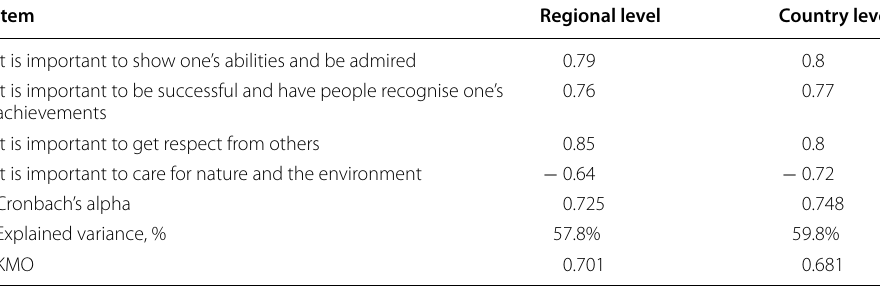
Source: calculated from European Social Survey